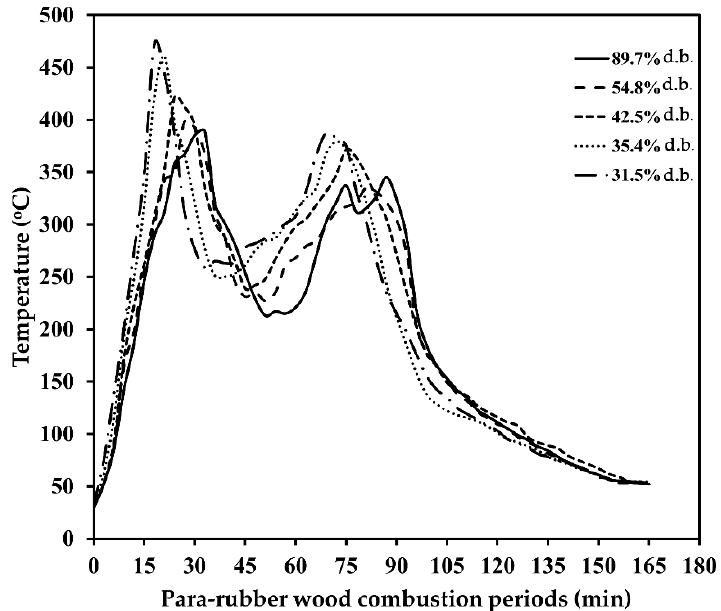
Figure 3. The temperature at 500 mm above the base of the fire for the different para rubber wood moisture contents.